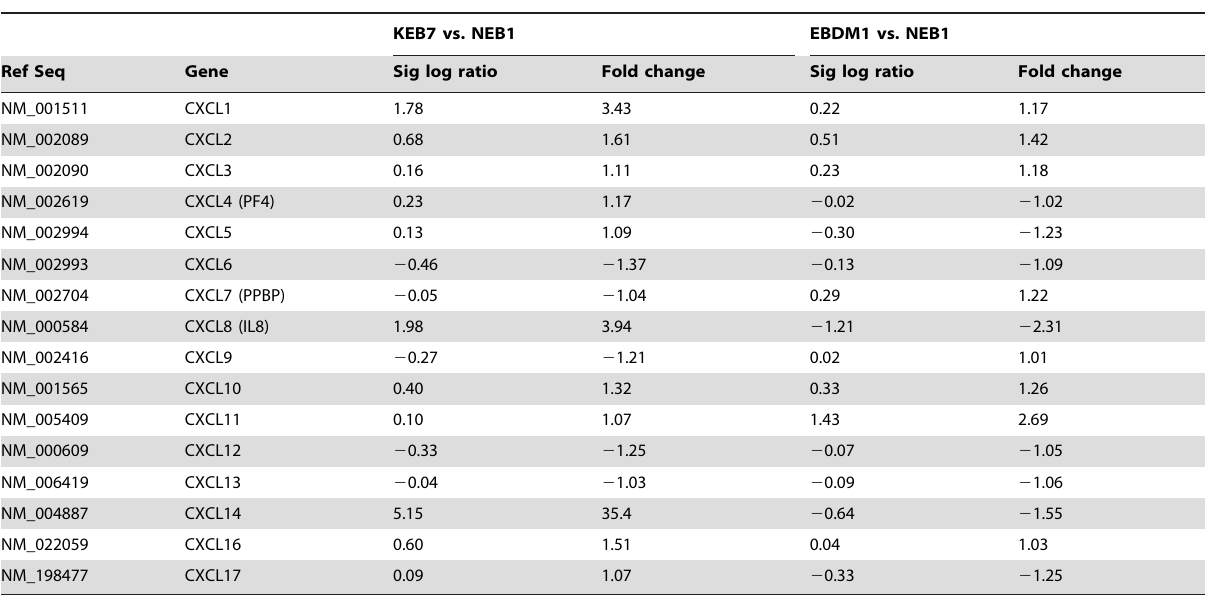
Table 7. Microarray analysis of C-X-C chemokines.